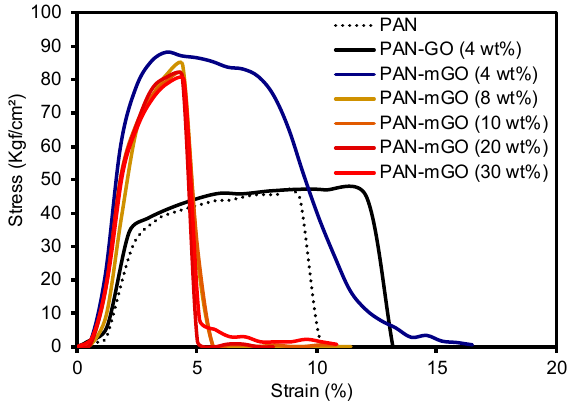
Figure 2. FTIR of GO, mGO, and cetyltrimethylammonium chloride (CTAC) indicates that the mGO is successfully prepared.